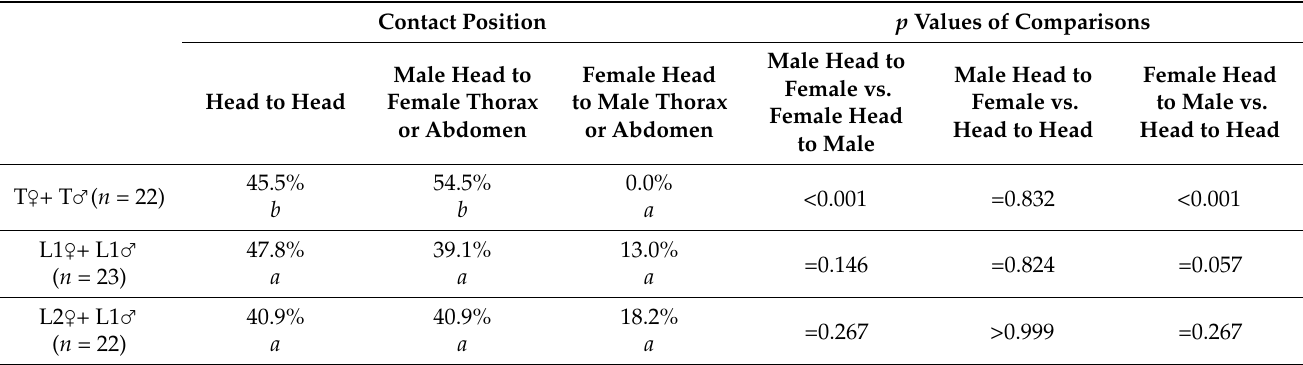
Table 9. Percentage of the first contact positions during the precopulation. Contact Position p Values of Comparisons